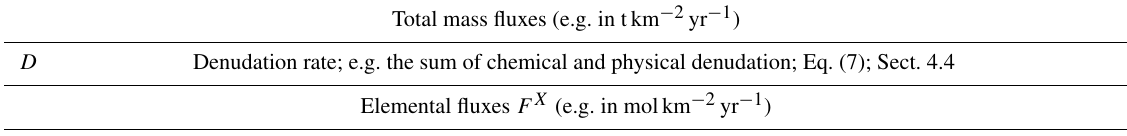
Table 1. Glossary of